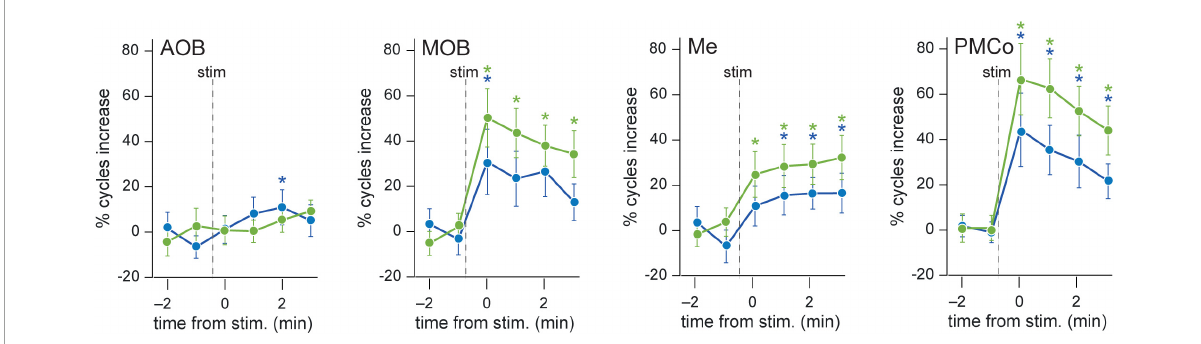
FIGURE5 Evolution of theta-nested components upon stimulus presentation. Proportion of theta cycles coupled to nested components per minute, before and after neutral (blue) or conspecific (green) stimuli. Wilcoxon test comparing the basal against post-stimulus values, * p < 0.05.